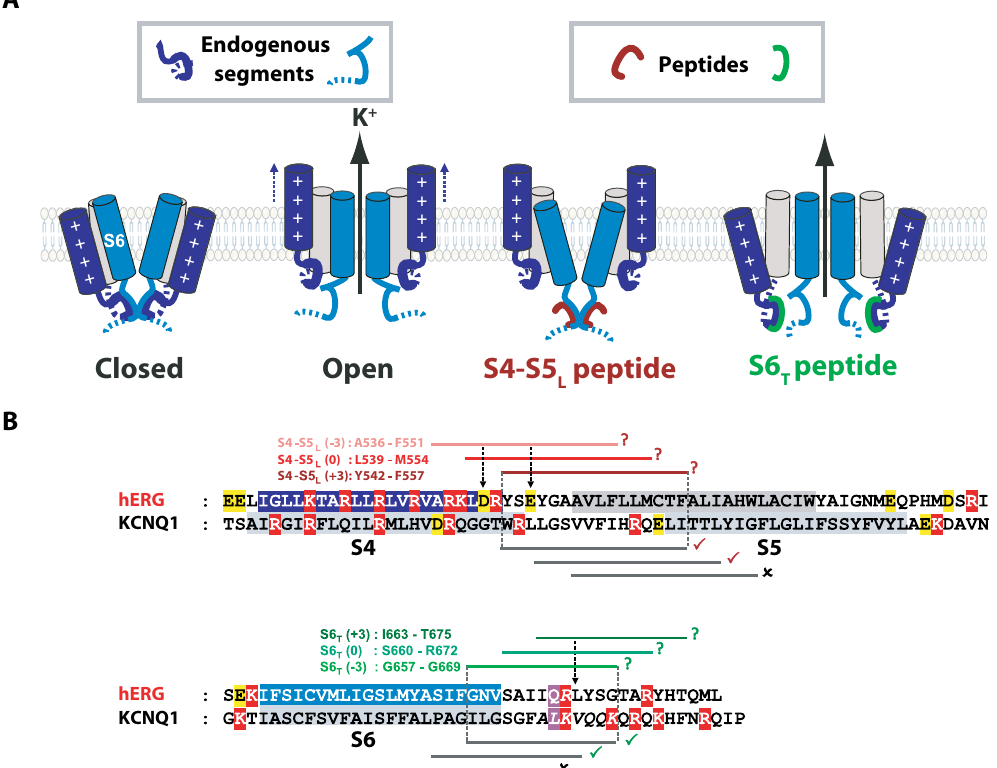
Figure 1. Hypothetical ligand/receptor model. Alignment used to design S4-S5 L and S6 T peptides. ( A ) Scheme of the hypothetical ligand/receptor model in which S4-S5 L (deep blue) binds to S6 T (light blue) to stabilize the channel in a closed state. Upon membrane depolarization, S4 pulls S4-S5 L out of the S6 T receptor, allowing channel opening. The S4-S5 L peptide (red) mimics endogenous S4-S5 L , locking the channel in its closed conformation. Contrarily, S6 T peptide (green) binds to the endogenous S4-S5 L and limits its locking effect, leading to channel up-modulation. ( B ) Alignment used to design hERG peptides from previously identified KCNQ1 S4-S5 L and S6 T peptides (based on the multiple alignment obtained using Clustal Omega, presented in Supplemental Fig. 4). In red are represented the basic residues, in yellow acidic residues, and in purple the position of the narrowest part of the bundle crossing, also named the gating residue (see methods). The color boxes represent the transmembrane segments. Grey lines represent the peptides tested in KCNQ1 while red lines and green lines represent the designed hERG S4-S5 L and S6 T peptides, respectively. A check sign (✓) indicates that the KCNQ1 S4-S5 L peptide inhibits the channel (red) and that the KCNQ1 S6 T peptide activates the channel